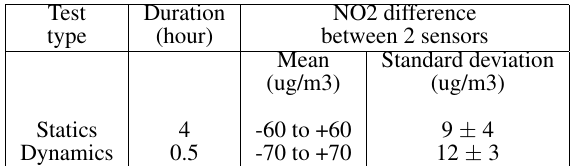
Table 2. NO2 concentration differences of AirCrowd sensor